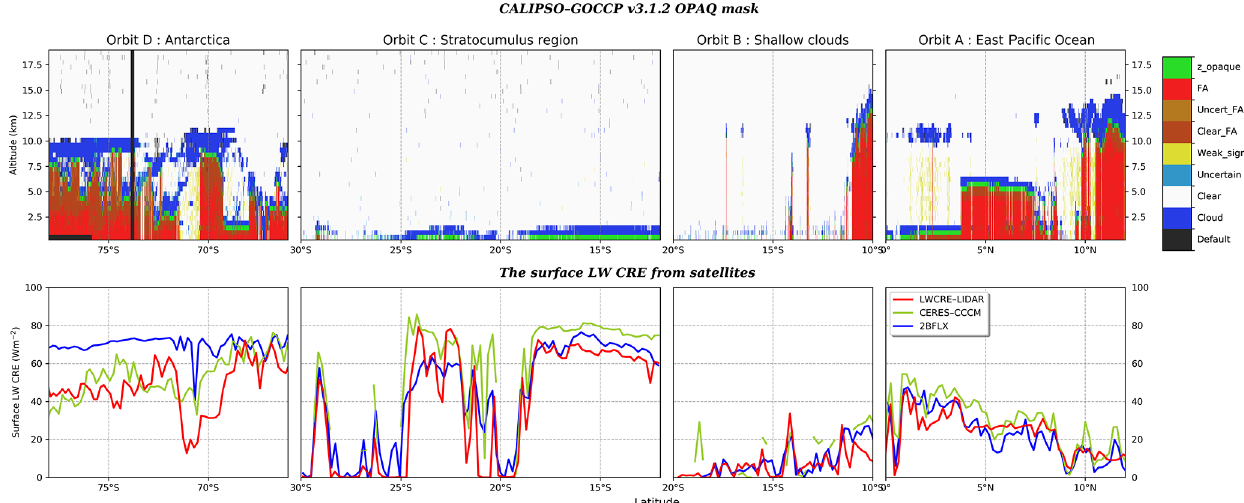
Figure 12. Pieces of CALIPSO orbits passing over (a) the eastern Pacific Ocean on 17 October at 08:21:48LST, (b) the shallow cloud region in the Pacific Ocean on 5 April at 12:55:34LST, (c) the stratocumulus region on 13 July at 06:48:37LST, and (d) Antarctica on 21 September at 03:09:46LST. The four orbit pieces are extracted during the year 2008. Top line: vertical feature mask from the CALIPSO–GOCCP–OPAQ product (Guzman et al., 20017); the black areas below 4km correspond to land. Bottom line: surface LW CRE of the three satellite products. The locations of the pieces of orbit (a, b, c, d) are reported in Fig. 14.